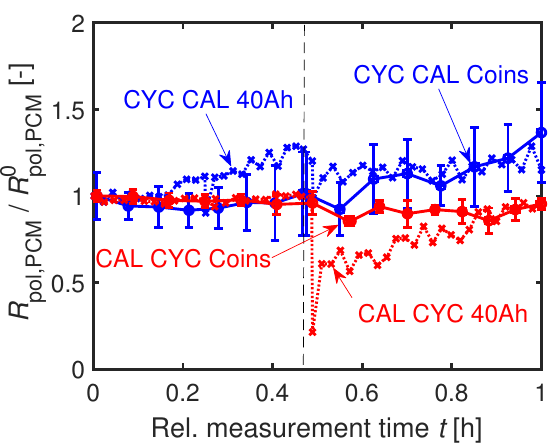
Figure 18. Relative development of R pol,PCM scaled to the initial value at BOL R 0 Similar trend of R pol,PCM / R 0 of the 40Ah cell and the coin pol,PCM